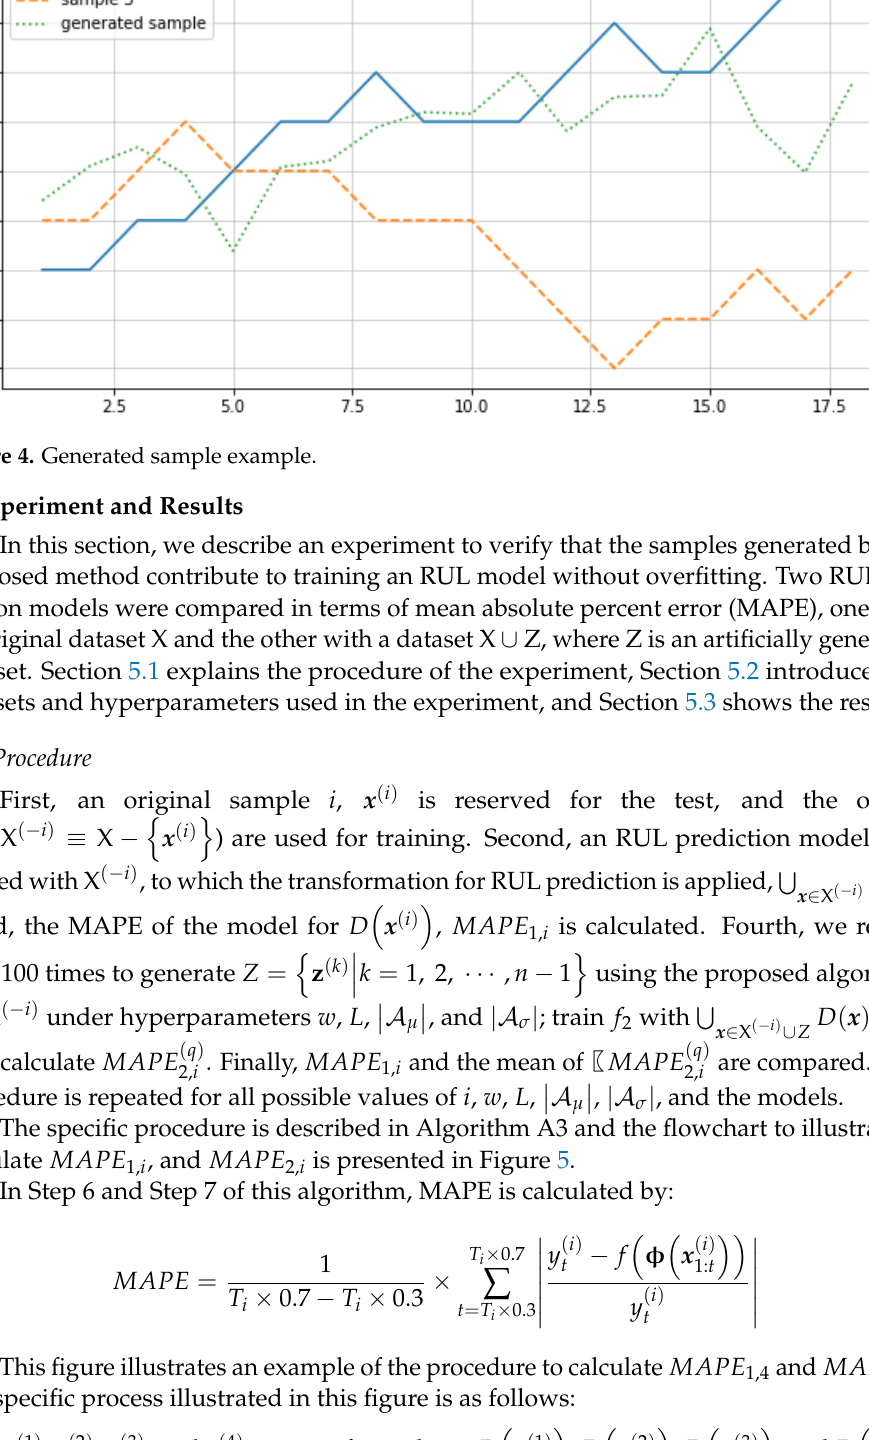
Figure 4. Generated sample